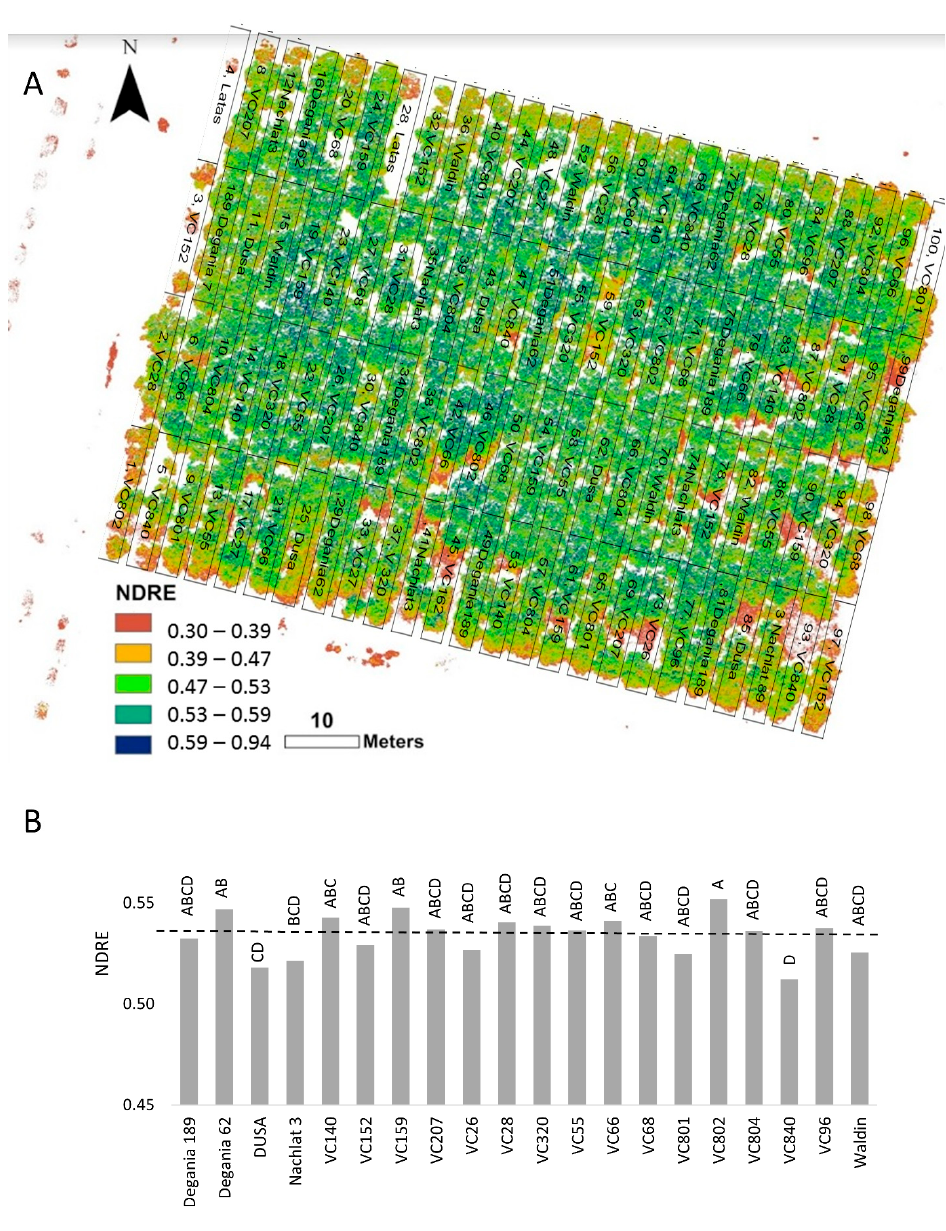
Figure 6. Normalized difference red edge (NDRE) index of ‘Hass’ avocado trees grafted onto various rootstocks, after 18 months of salinity exposure. ( A ): NDRE mosaic visualization over the orchard map. ( B ): average NDRE values according to rootstock. Different letters represent significant ( p ≤ 0.05) differences between rootstocks. The dashed line represents the 0.53 NDRE value, above which plants are considered non-stressed (see https://micasense.com/what-is-ndre, accessed on 10 August 2021). SD values are presented in Table S1.